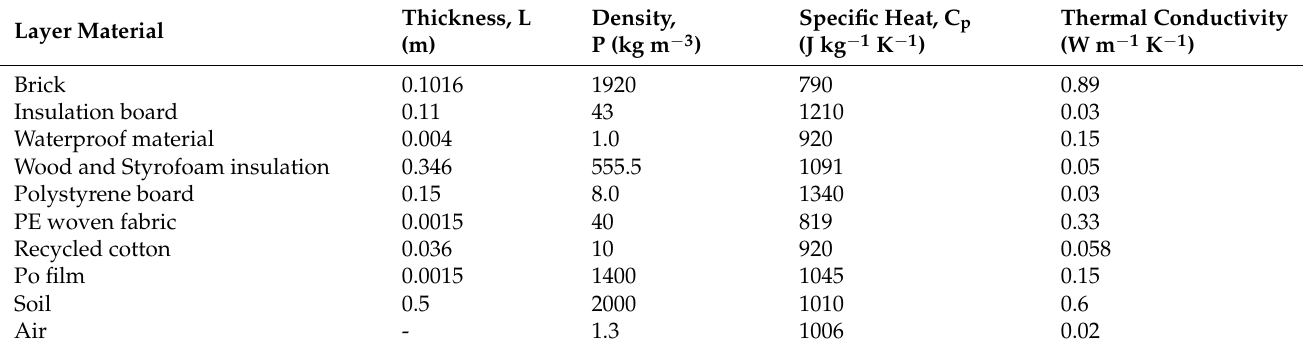
Table 2. Physical properties of surfaces used in the simulation.